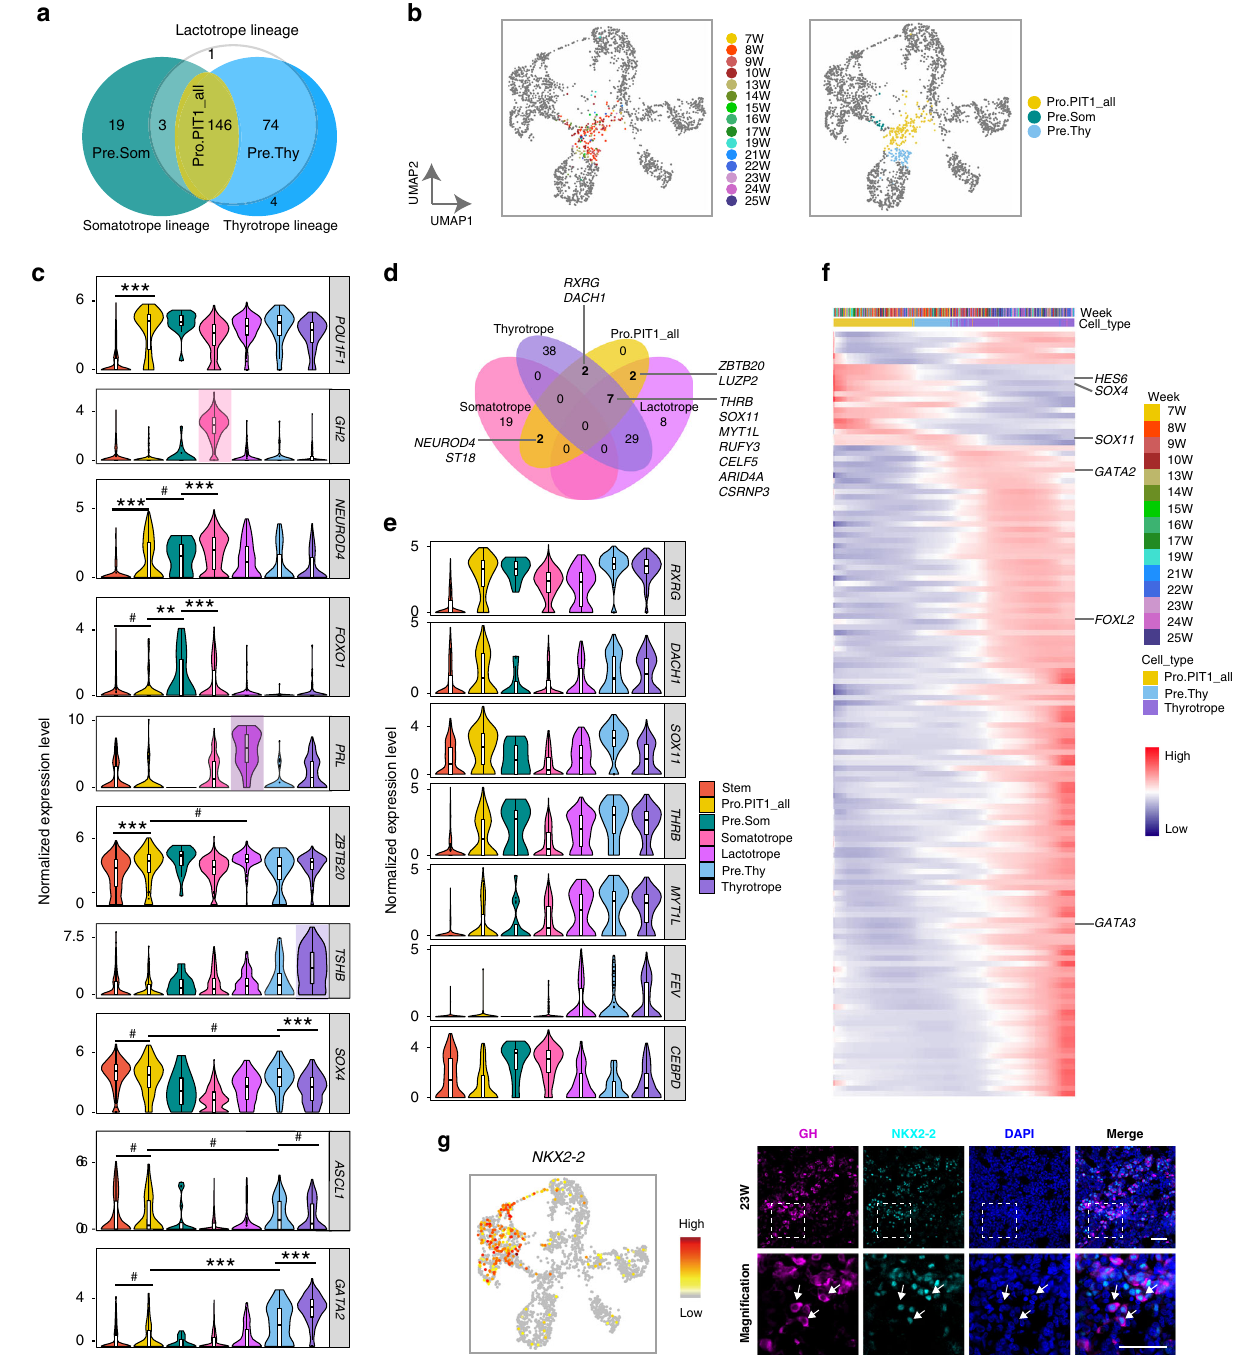
Fig. 6 Differentiation trajectories and TF dynamics of the PIT-1 Lineage. a Venn diagram of progenitor cells distributed in each PIT1 sublineage as shown in the pseudotime analysis. Pro.PIT1_all: the common progenitor cells of all three sublineages; Pre.Thy, the precursor cells of thyrotropes; Pre,Som: the potential precursor cells of somatotropes. b Distribution of the subtypes of the Pro.PIT1 on the UMAP plot. Dots: single cells; colors: weeks postfertilization (left) or cell types (right). c Violin and inside box plots showing the gene expression dynamics of known TFs for each PIT1 lineage. # P > 0.1, ** P < 0.01 *** P < 0.001. P -values are determined by two-sided Wilcoxon test and adjusted by Bonferroni correction. d Venn diagram showing the intersections among the differentially expressed TFs between any two of the three PIT1 lineages, and the 13 TFs that were signi fi cantly upregulated in the Pro.PIT1_all cells in comparison with the stem cells, for which the names of genes are shown. e Violin with inside box plots showing representative identi fi ed TFs for each PIT1 lineage. f Heatmap showing the relative expression levels of the signi fi cantly upregulated TFs of thyrotropes along the pseudotime axis. Colors: loess-smoothed expression (red, high; blue, low). The columns represent cells being ordered along the pseudotime axis, and cell type information is shown above the heatmap. Rows represent genes being ordered by their peak expression along the pseudotime axis. g The scatterplot (left) expression and immuno fl uorescence staining of NKX2-2 as a somatotrope-speci fi c TF. Scale bar, 50 μ m. Arrows indicate representative cells co-expressing GH and